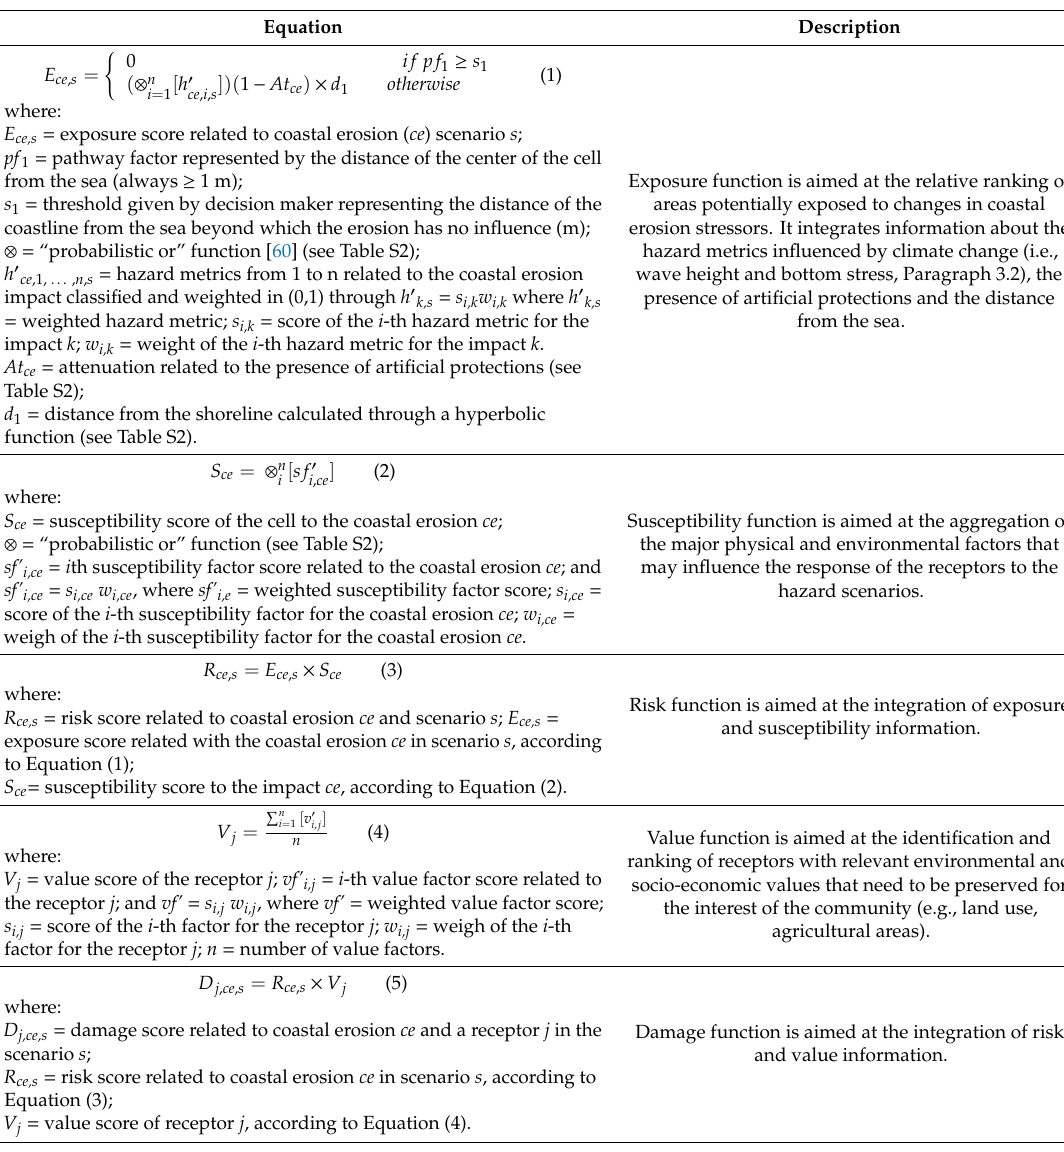
Table 4. Equations applied for the assessment of climate change impact on coastal erosion risk in the NA coast.